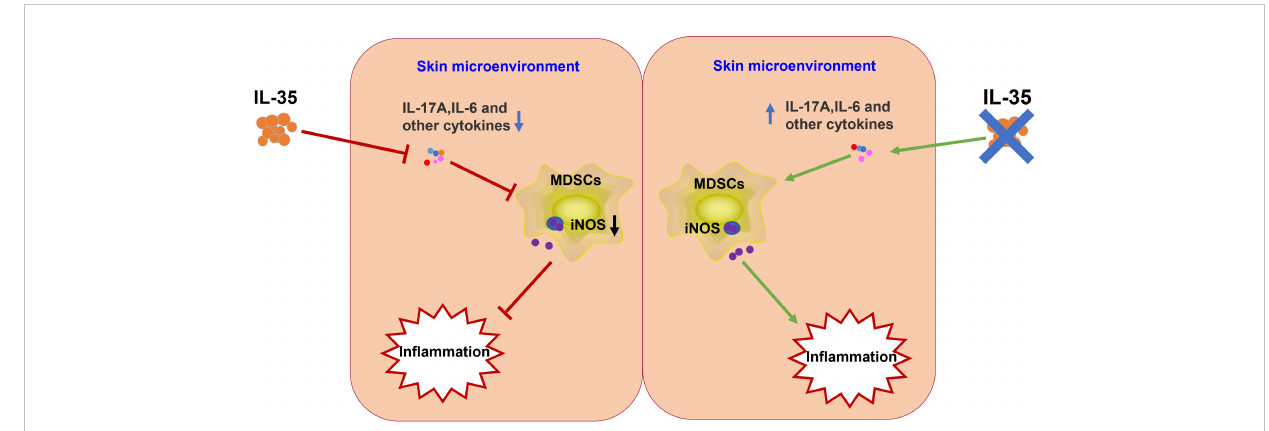
FIGURE 10 Schematic illustration of the potential mechanism underlying IL-35 amelioration of psoriasis. IL-35 inhibits proin fl ammatory factors in the skin microenvironment. These proin fl ammatory factors induce the differentiation and recruitment of MDSCs. Therefore, IL-35 may indirectly inhibit iNOS secretion from MDSCs. IL, interleukin; iNOS, inducible nitric oxide synthase; MDSC, myeloid-derived suppressor